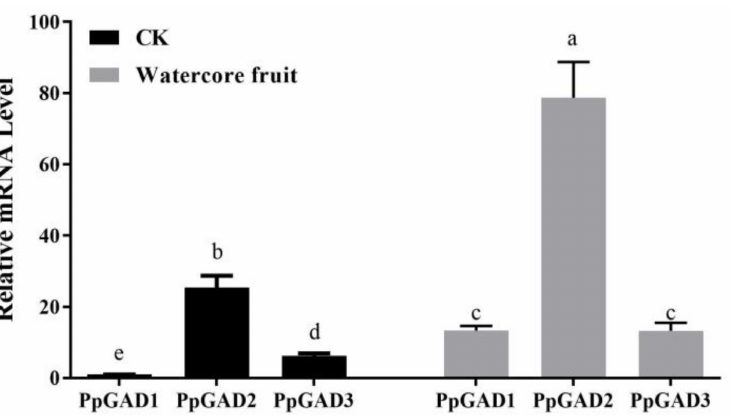
Figure 2. Analysis of PpGADs’ expression in the ‘Akibae’ watercore fruits. CK refers to healthy fruit. The lower case letter on the bars represent standard errors from three independent